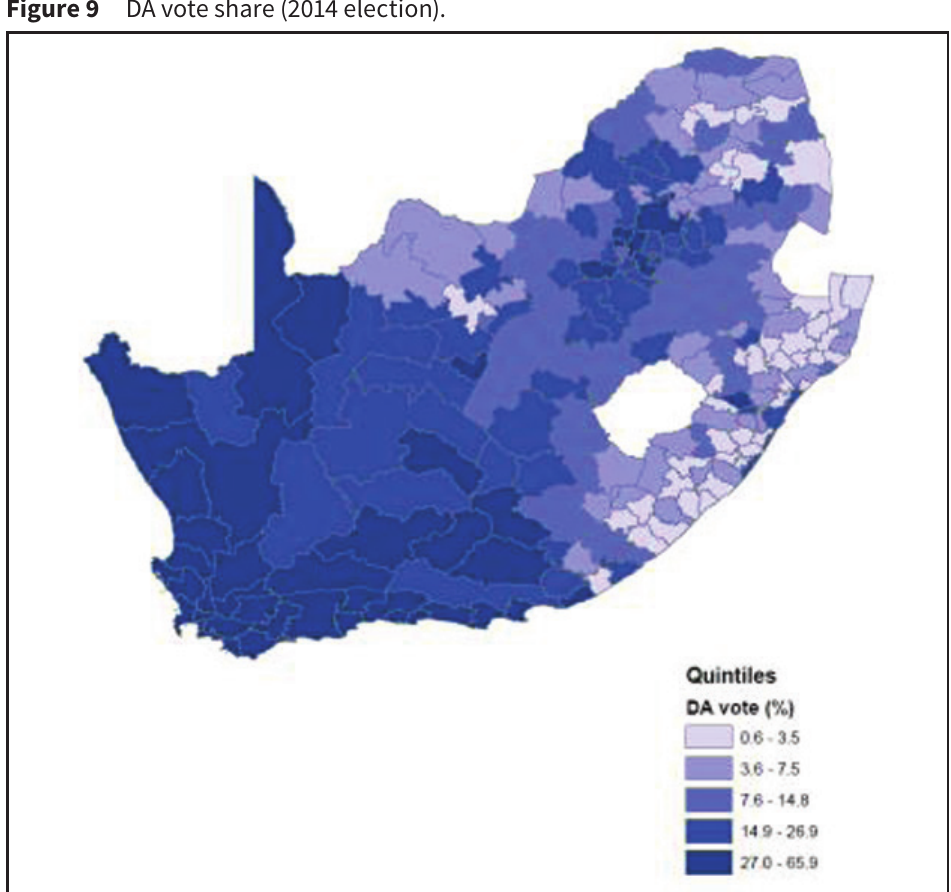
DA vote share (2014